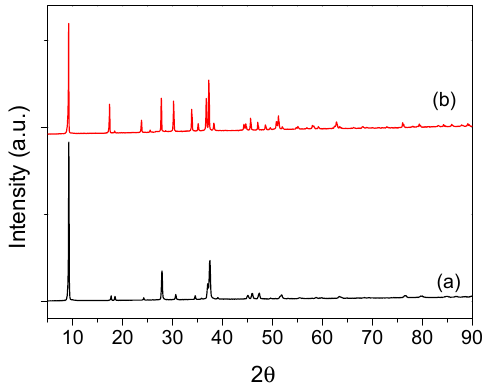
Figure 1. X-ray patterns of as-synthesized hybrid copper perovskites powders: ( a ) MA 2 CuCl 2 Br 2 and ( b ) MA 2 CuCl 0.5 Br 3.5 .